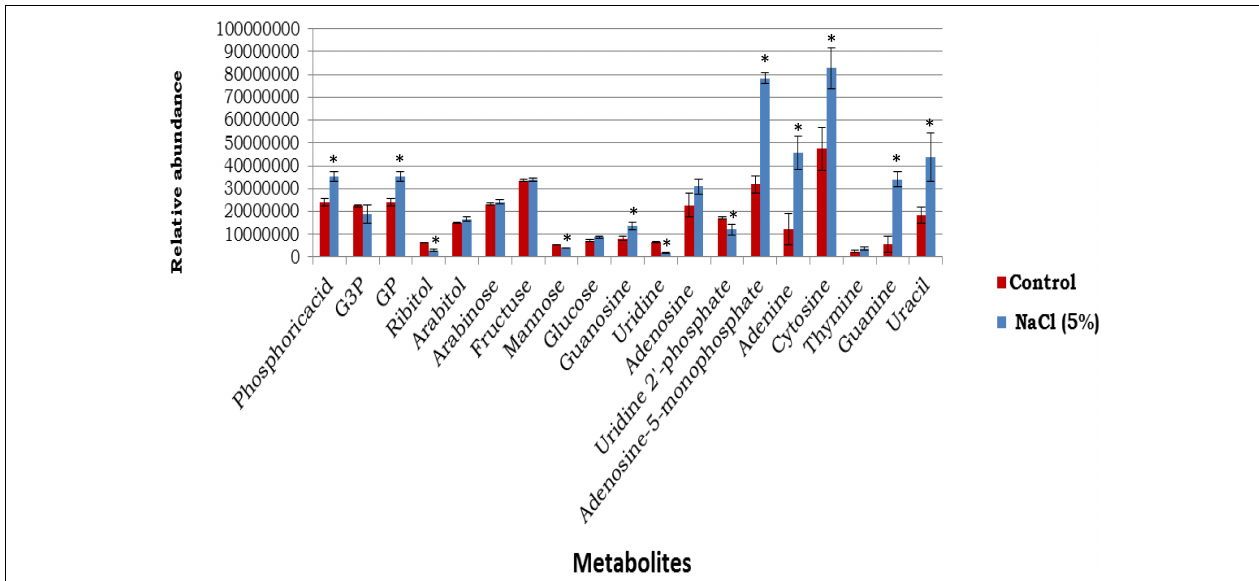
FIGURE 5 | The abundances of cytoplasmic metabolites extracted from cells incubated in a defined medium (reference control, n = 4) compared with equivalent sets of cells that were incubated in the defined medium supplemented with 5% NaCl ( n = 3) (mean ± SD). ∗ p < 0.05. *Signicantly altered metabolites.